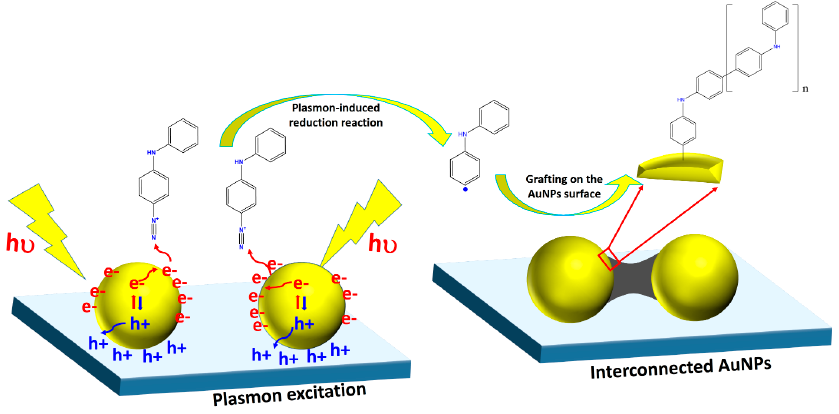
Figure 1. Scheme of the plasmon-induced grafting process of ADP oligomers on AuNPs.